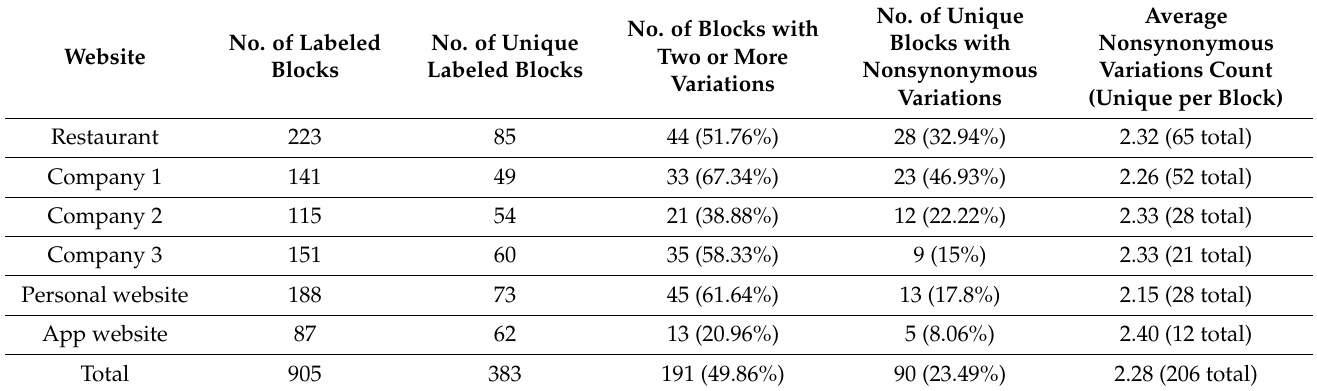
Table 3. Websites labeling results obtained from respondents during the